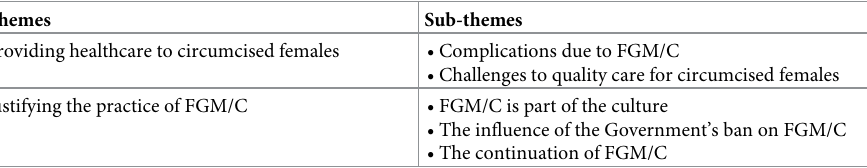
Table 2. Themes and sub-themes emerging from the